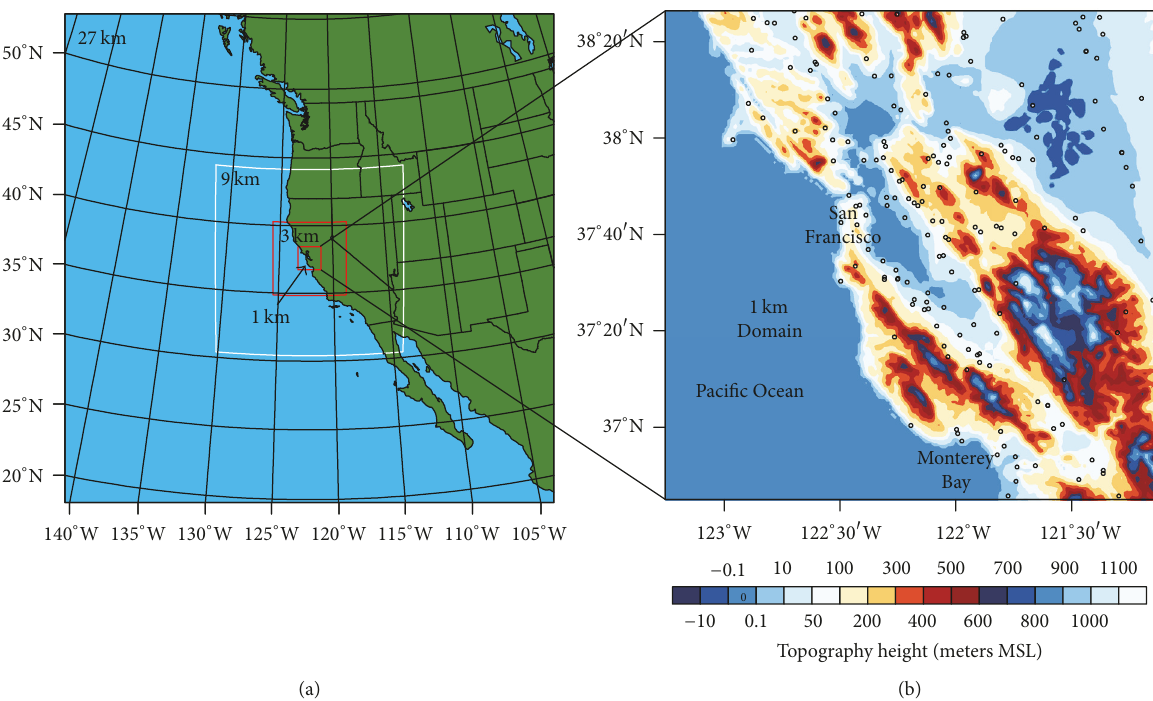
Figure 1: (a) Placement of the four nested WRF-ARW domains, and (b) the topography of the 1km horizontal grid spacing domain with locations of land-based surface observations during the 1–6h forecast on 7 February indicated by black circles with a white circle